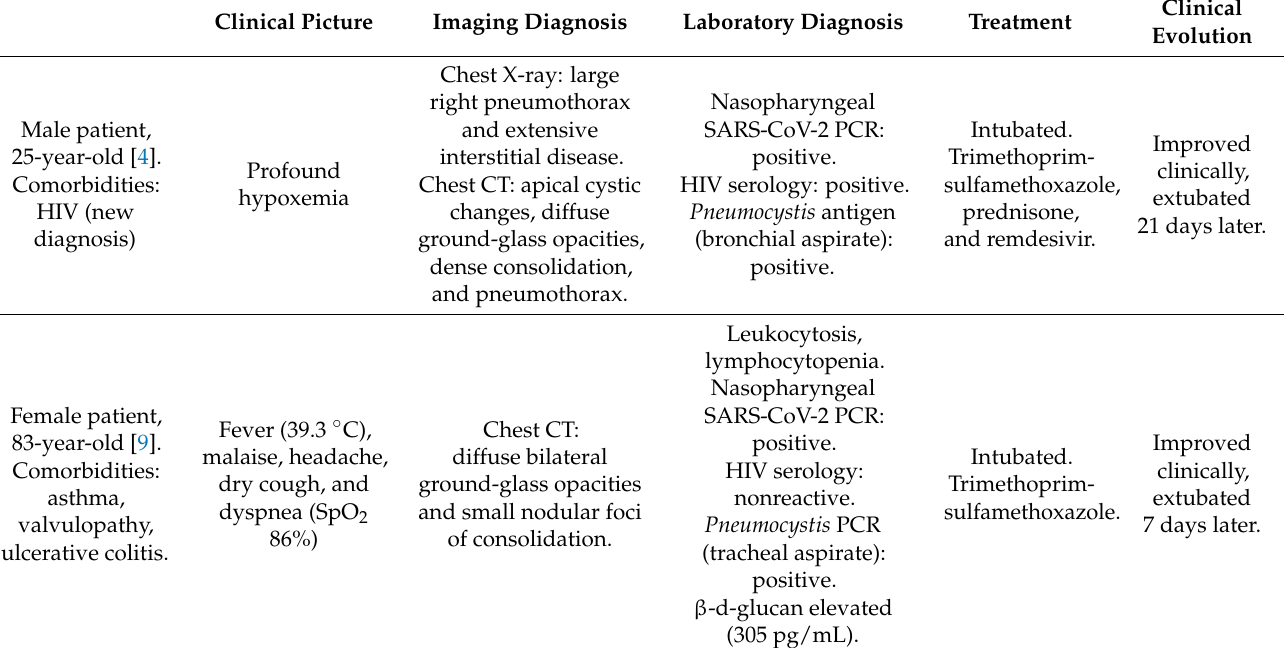
Table 1. Reported COVID-19 and Pneumocystis coinfection